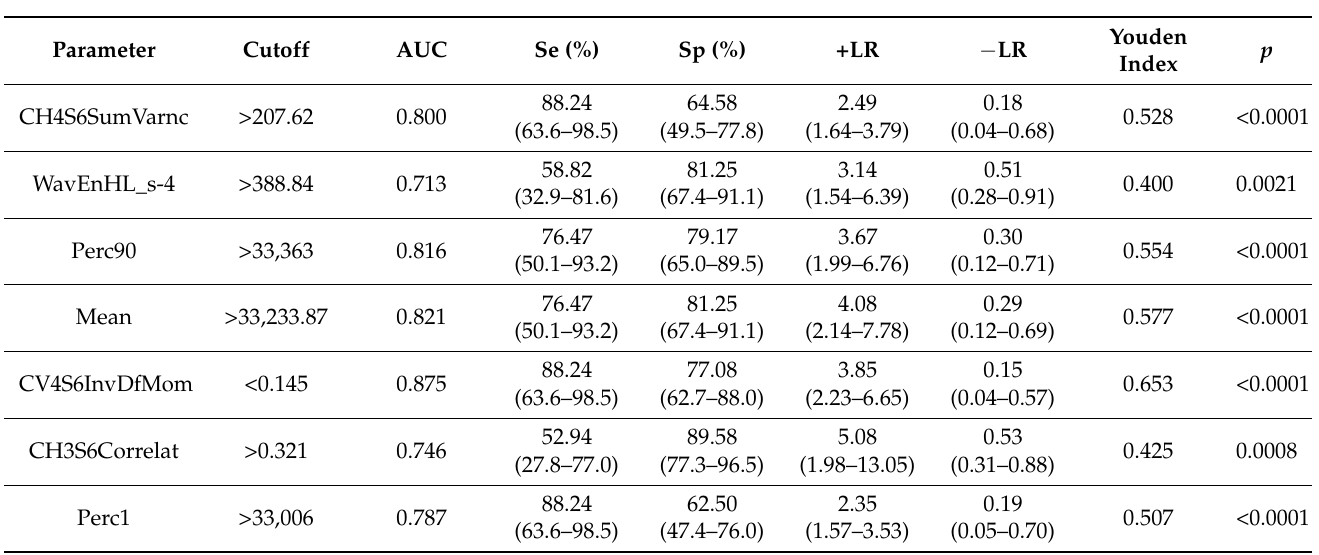
Table 4. The receiver operating characteristic analysis results for texture parameters associated with the lymphomatous transformation of the parotid gland’s parenchyma in patients with primary Sjögren’s